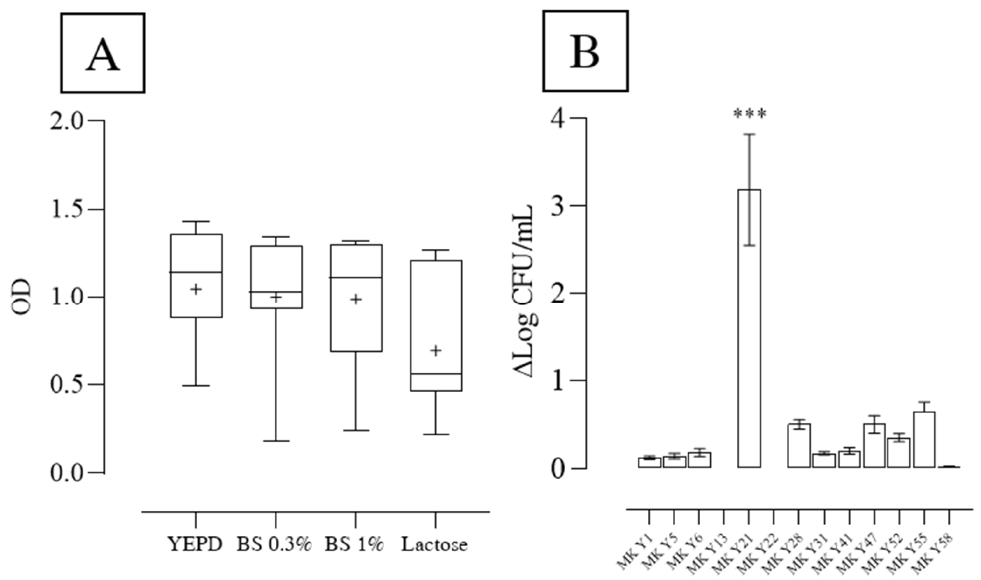
Figure 2. ( A ) Box plot representing microbial growth determined by measuring the absorbance in YEPD medium, YEPD medium with 0.3% of bile salts (BS 0.3%), YEPD medium with 1% of bile salts (BS 1%), and in YEPD medium with lactose as carbohydrate (lactose), of the 13 yeast strains isolated from spontaneous raw milk fermentation. The center line of each box represents the median, the mean is indicated by “+”, the top and bottom of the box represent the 75th and 25th percentile, respectively. ( B ) Differences in yeast cell counts (mean ± standard deviation, n = 3) between the initial concentration and after 4 h in acidic conditions (*** p < 0.001).